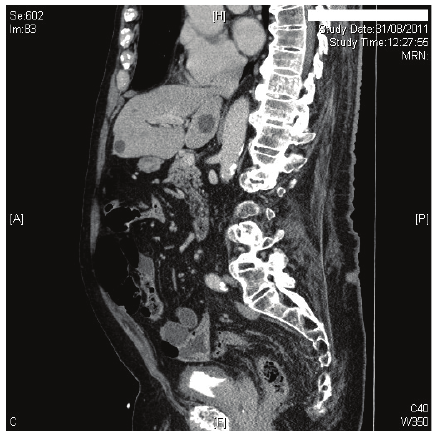
Figure 2: CT urography (sagittal view) revealed an irregular mass at the base of urinary bladder, which was likely to be an irregularly enlarged median lobe of prostate rather than intrinsic bladder